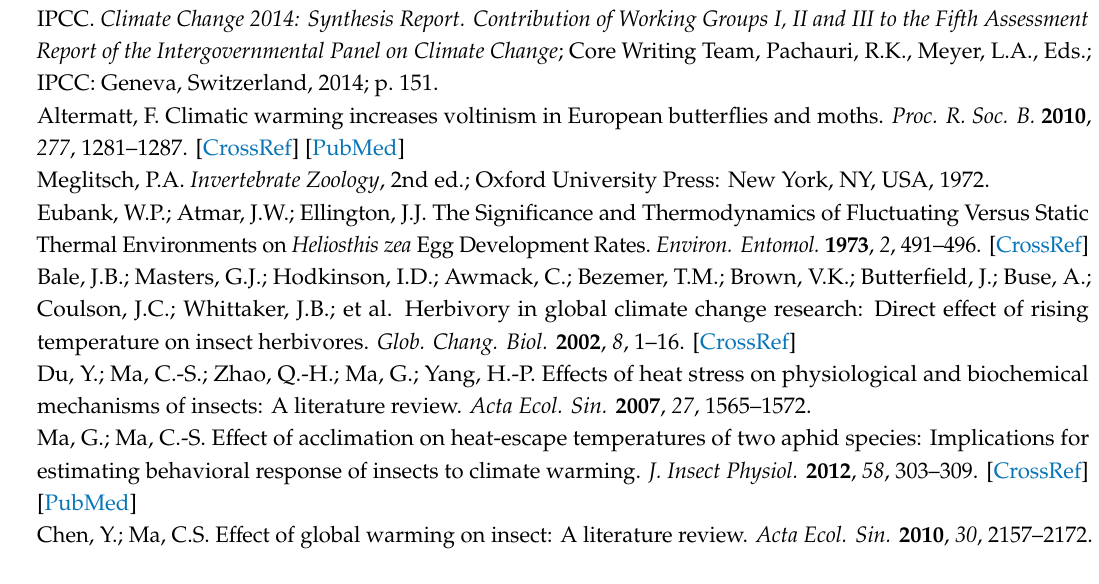
Table S1: A list of source references for retrieving the phenological data of the three aphids used in this study. Figure S1: The data collection sites of the three aphids used in this study. ( a ) Myzus persicae ; ( b ) S. avenae ; ( c ) A. gossypii (blue, northern Xinjiang; cyan, southern Xinjiang); ( d ) All three aphid